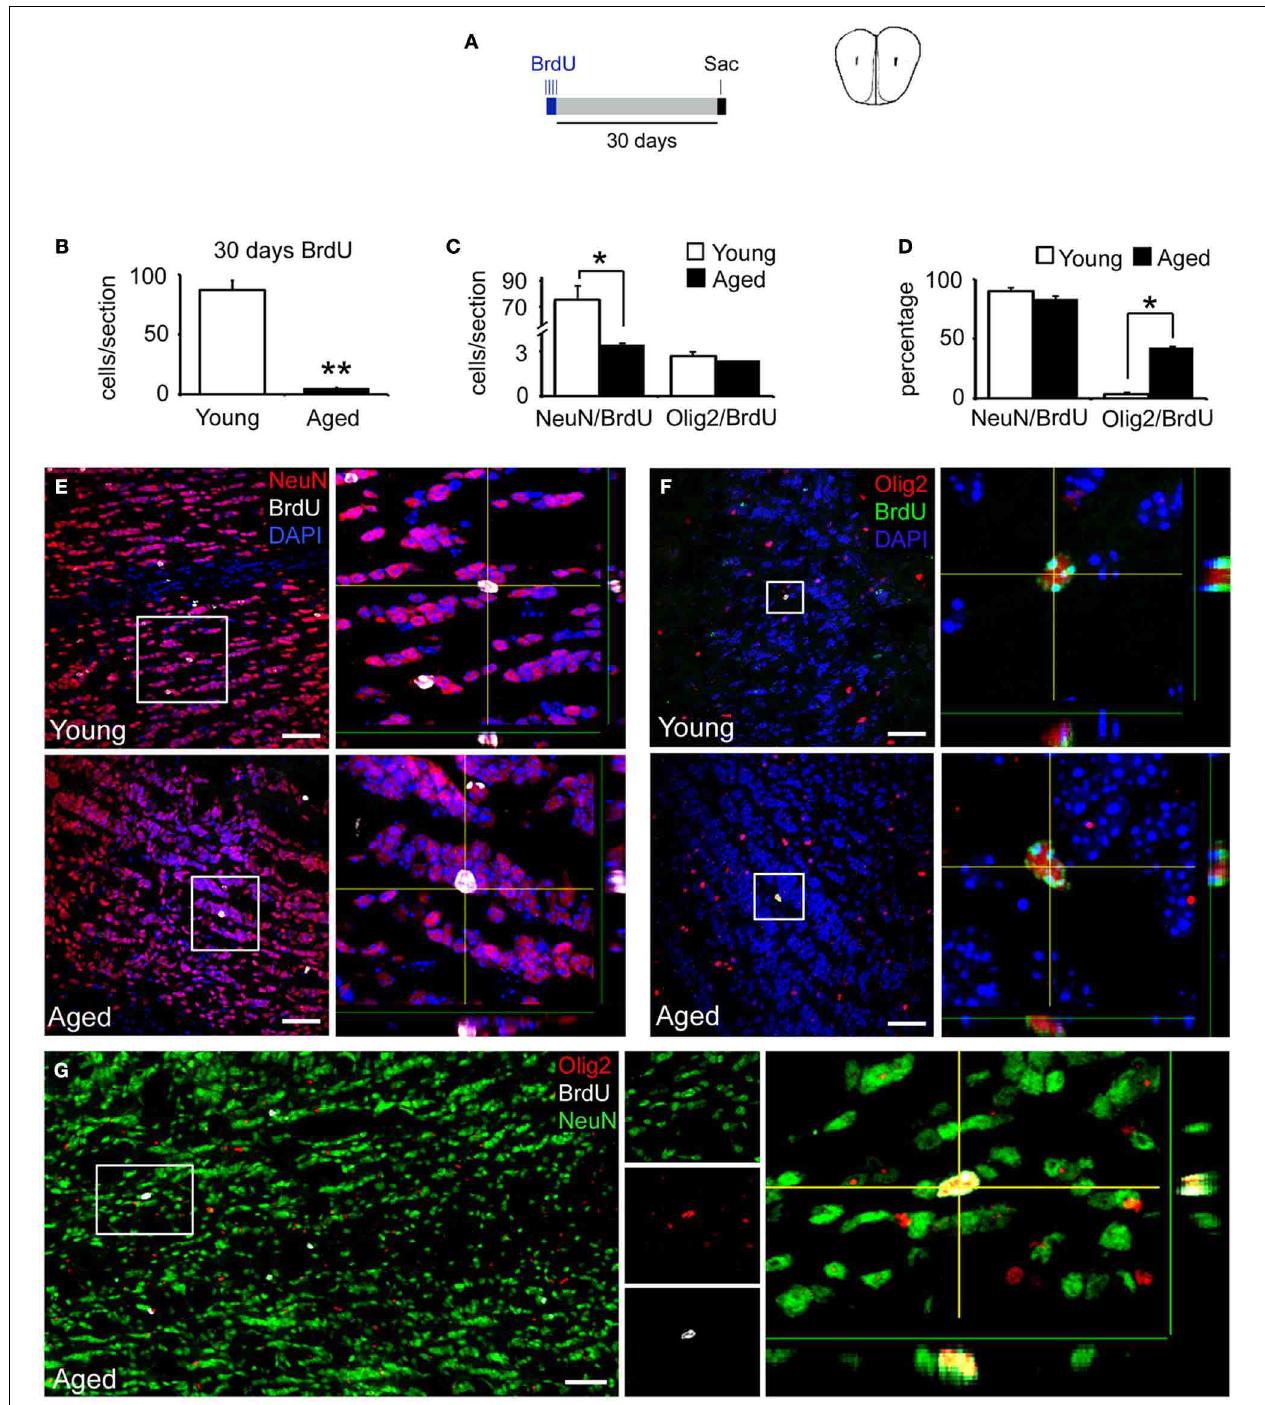
FIGURE 6 | Aging decreases neurogenesis, but not oligodendrogenesis in the OB. (A) The animals received 4 doses of BrdU, separated by 2h, and were euthanized 30 days after. (B) Bar graph depicting a significant reduction of BrdU + cells in the aged OB, 30 days after treatment. (C) Bar graph depicting the number of NeuN and Olig2 + cells co-expressing BrdU marker. Note the decrease of newly generated neurons in aged mice, while the number of new oligodendrocytes remained unchanged. (D) Bar graph